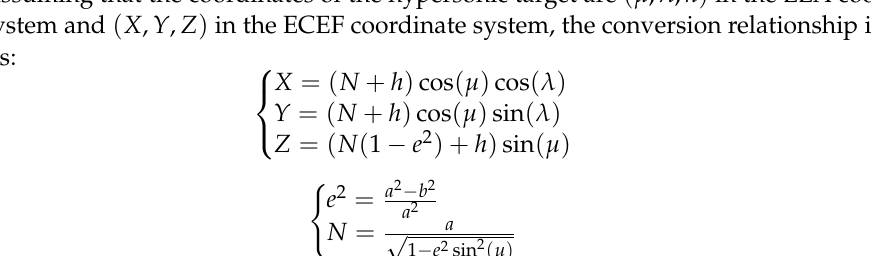
Figure 3. The geocentric coordinate system and reference coordinate system of the radar station. The radar position R is the origin of the coordinate system, and the RE , RN , and RU axes point to the east, north, and sky directions perpendicular to each other.